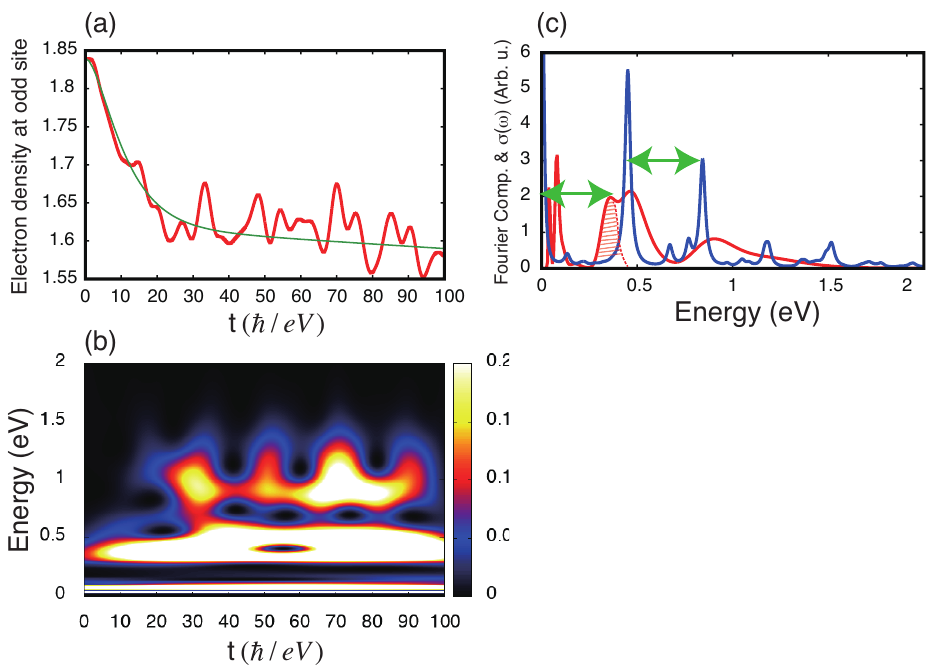
Figure 3. Dynamical behaviors for ∆ ef f = 0.28 eV during and after the pulse excitation with ¯ h ω c = 1.0 eV and τ d = 30 (¯ h /eV). ( a ) The site density at the odd-numbered site; ( b ) a spectrogram obtained from ( a ); and ( c ) the time integration of ( b ) (red line) and optical conductivity (blue line). The two green arrows in ( c ) show that the energy difference is the same at the two